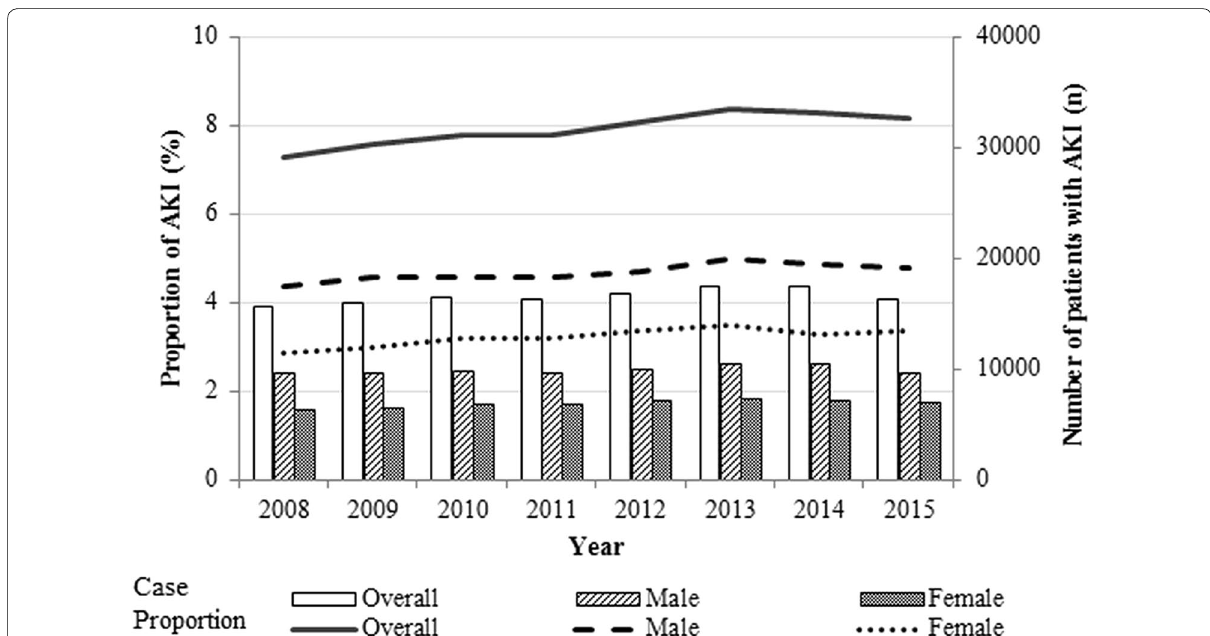
Fig. 1 Yearly trends of acute kidney injury in critically ill patients in Korea between 2008 and 2015. Bars represent absolute number of critically ill patients with acute kidney injury (AKI); lines represent proportion of critically ill patients with AKI among all ICU patients. Incidence increased from 7.4% in 2008 to 8.3% in 2015 ( p for trend <